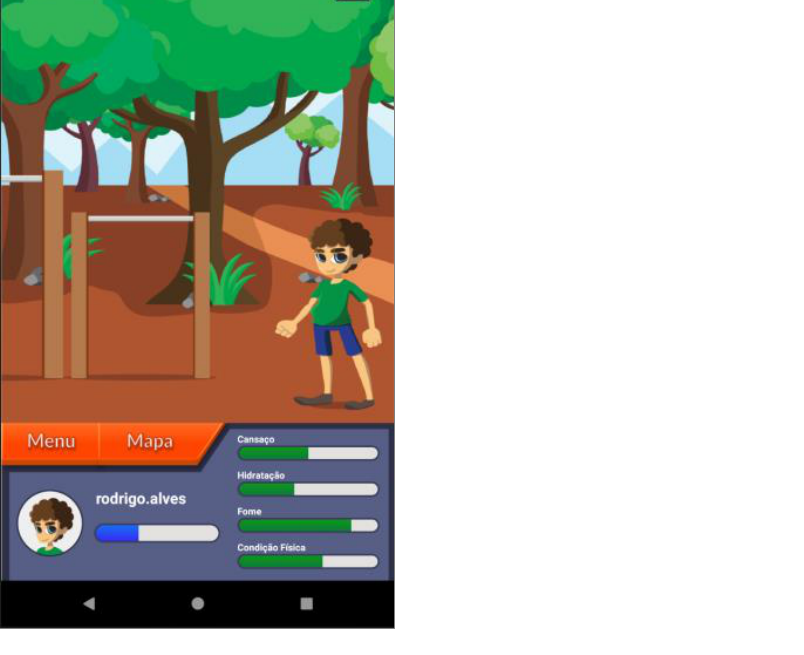
Figure 5. “Parque” (Park) section—presents the fatigue (“cansaço”); hydration (“hidratação”); hunger (“fome”) and physical condition (“condição física”)— affordance; consistency.